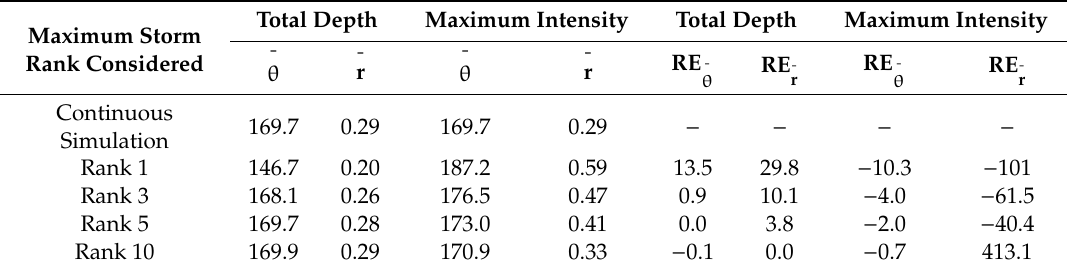
Table 3. Seasonality of the maximum annual peak-flow represented by the angle of its mean direction ( θ ) and its radio (r ), for di ff erent storm ranks and for the two di ff erent criteria studied. The relative error (RE) is also shown.